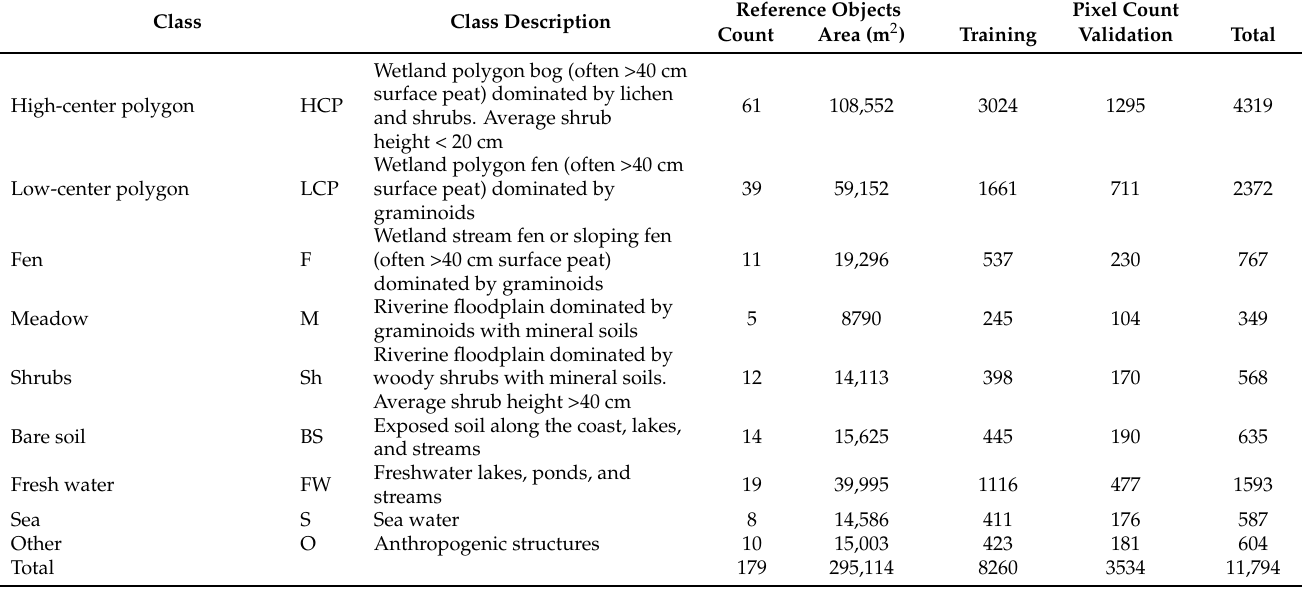
Table 2. Land cover class description including reference object size and training and validation pixel